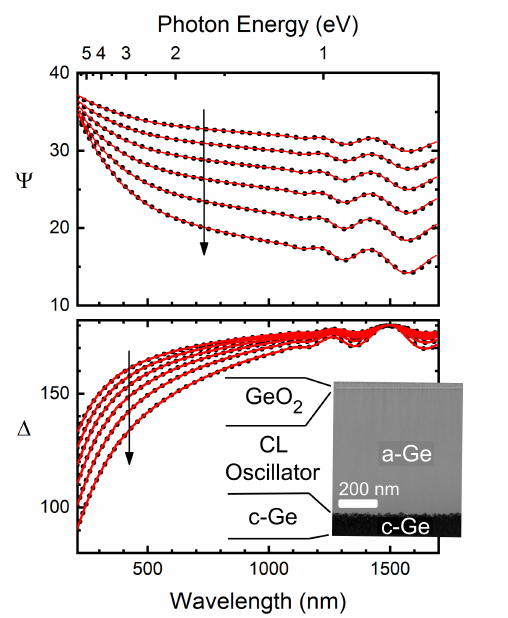
Figure 5. Measured and generated ellipsometric Ψ and ∆ spectra for the Al-implanted Ge sample. The two-layer optical model and the corresponding XTEM micrograph revealing a completely amorphized layer with a thickness of 681 nm is shown in the inset. The fitted thicknesses of the surface oxide (GeO 2 ) and the amorphous Ge (CL oscillator) layers are 1.74 ± 0.01 and 678.9 ± 0.1 nm, respectively. Note that the top part of the XTEM image is the glue used for the sample preparation. The 1.7-nm oxide itself is not visible. The arrows show the direction of increasing angles of incidence from 53 ◦ in steps of 3 ◦ .